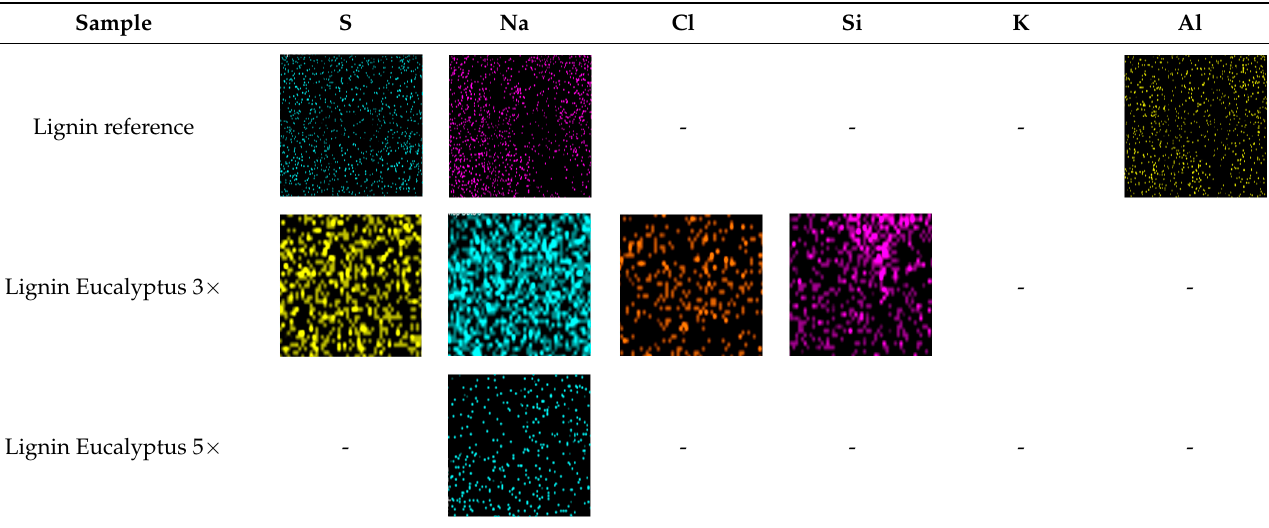
Table 5. FESEM-EDX analysis on lignin and lignosulphonate.